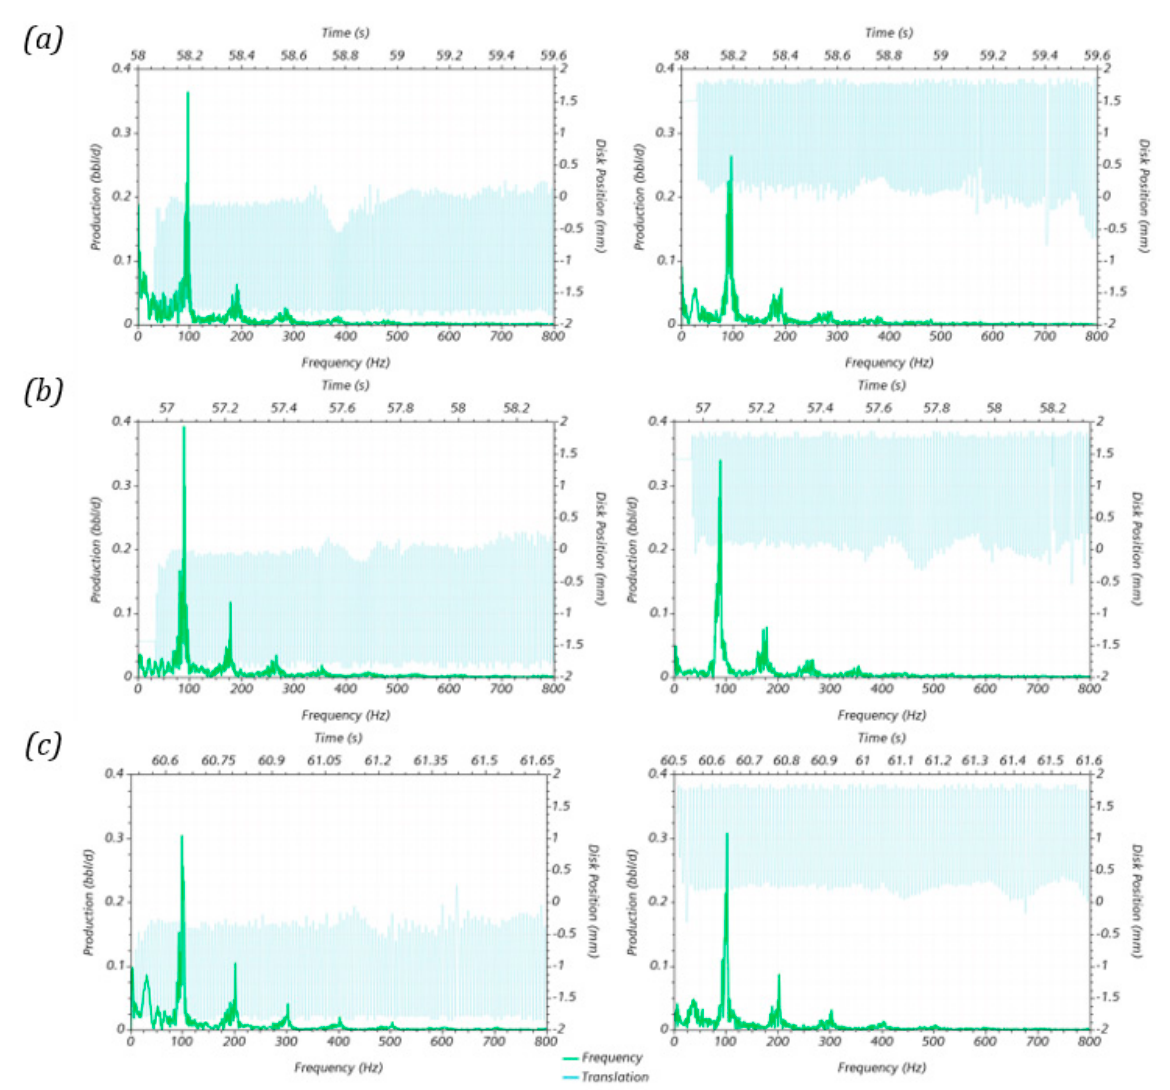
Figure 15. Results of the oscillation and frequency profile for the two RCP valves for the oil density sensitivity analysis: ( a ) ρ oil = 800, ( b ) ρ oil = 850, and ( c ) ρ oil = 900 kg/m 3